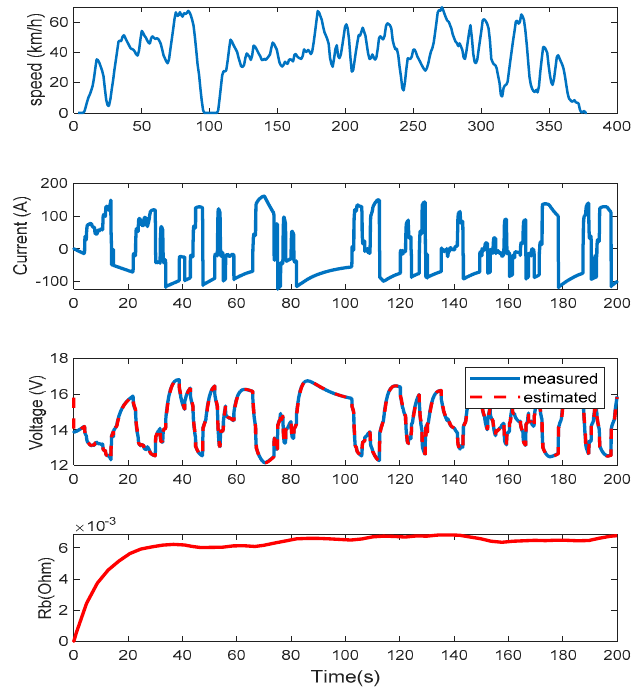
Figure 6. Battery internal resistance identification under a dynamic current profile (simulation).